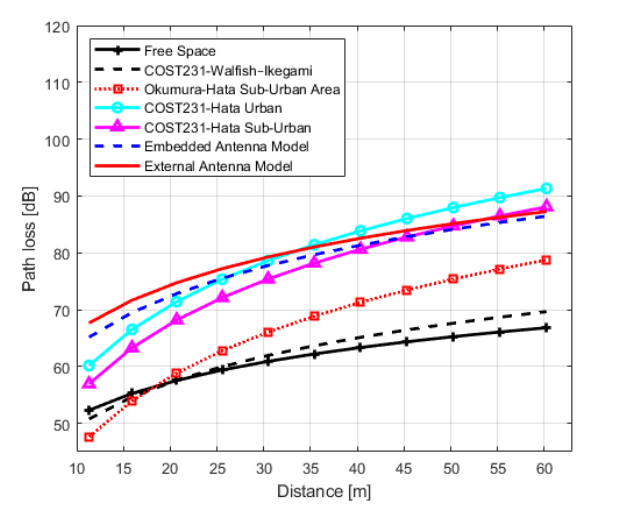
Figure 11. IQRF path loss model comparison with other models for Line-of-Sight scenario.